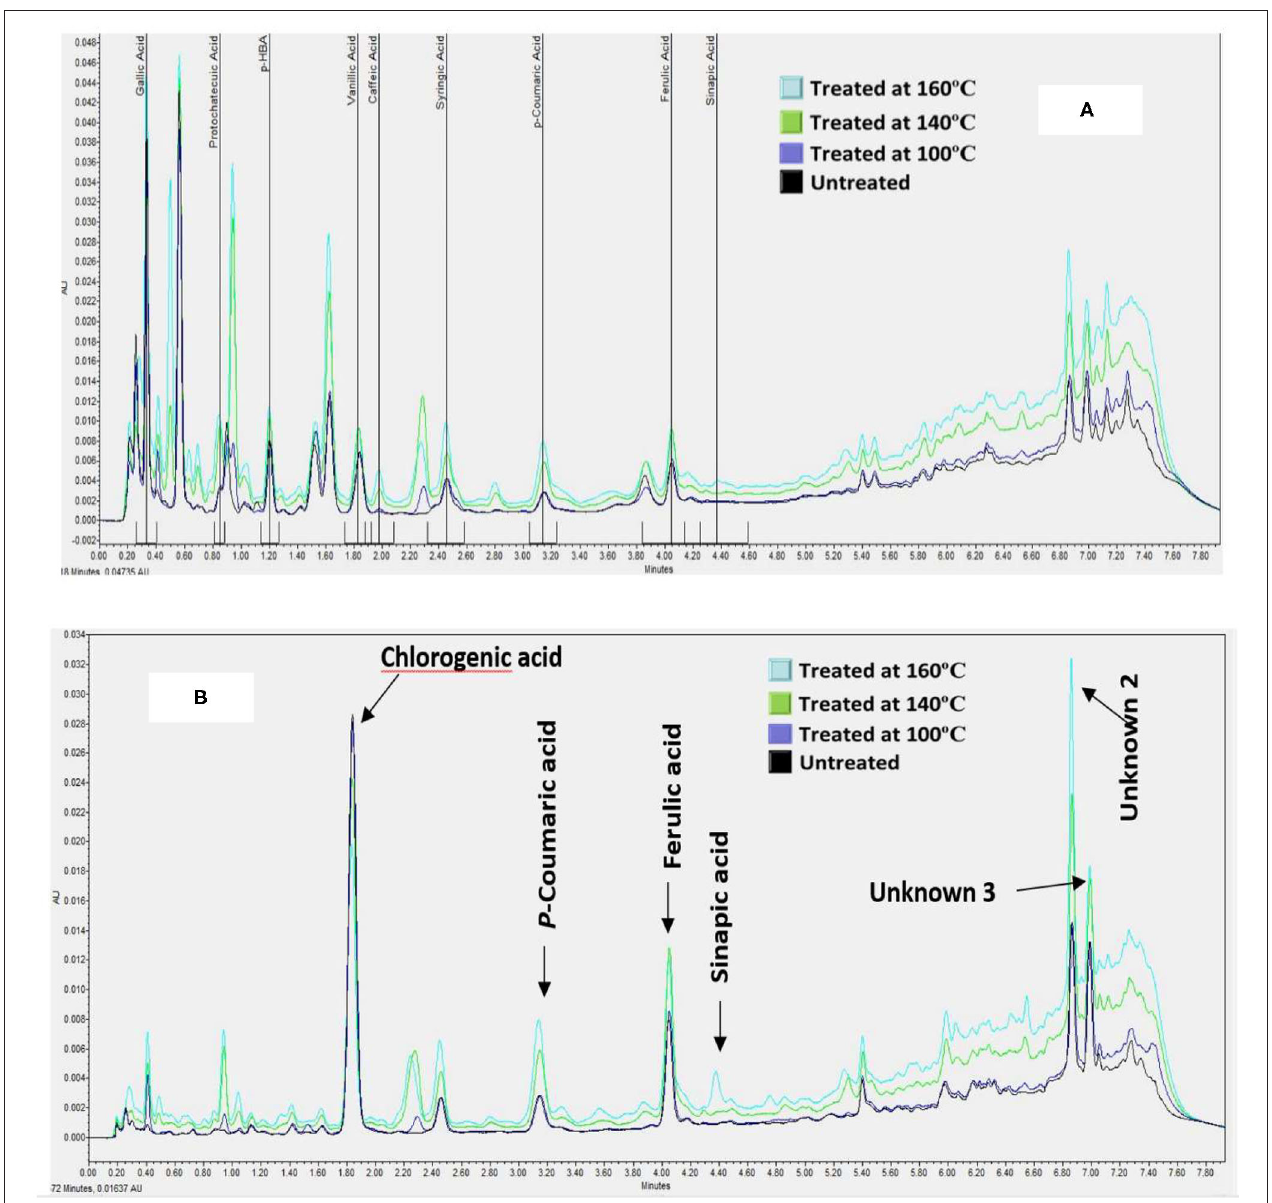
FIGURE 2 | A Chromatogram showing the effect of heat treatments on the composition of hydroxybenzoic acids [at 280nm, (A) ] and hydroxycinnamic acids [at 320nm, (B) ] of defatted BSG meal analyzed by UPLC-PDA.